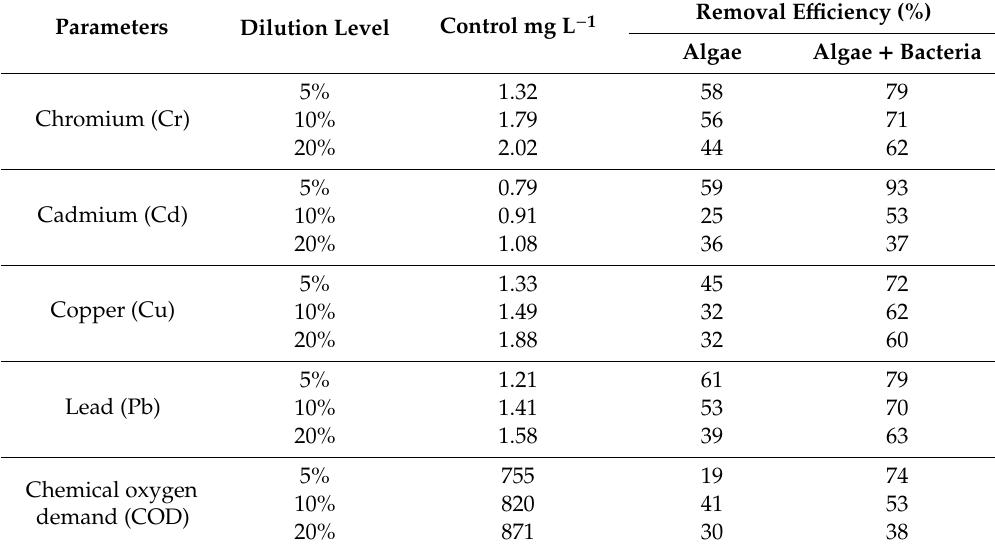
Table 1. Pollutant removal efficiencies of microalgae and microalgal–bacterial consortium from textile industry wastewater at different dilution levels.